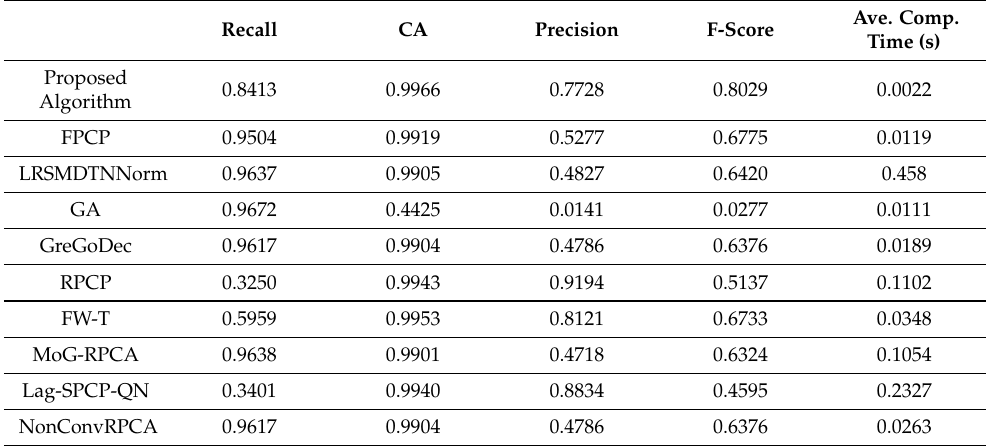
Table 3. Proposed technique foreground segmentation evaluation against different recent algorithms for Video 2.